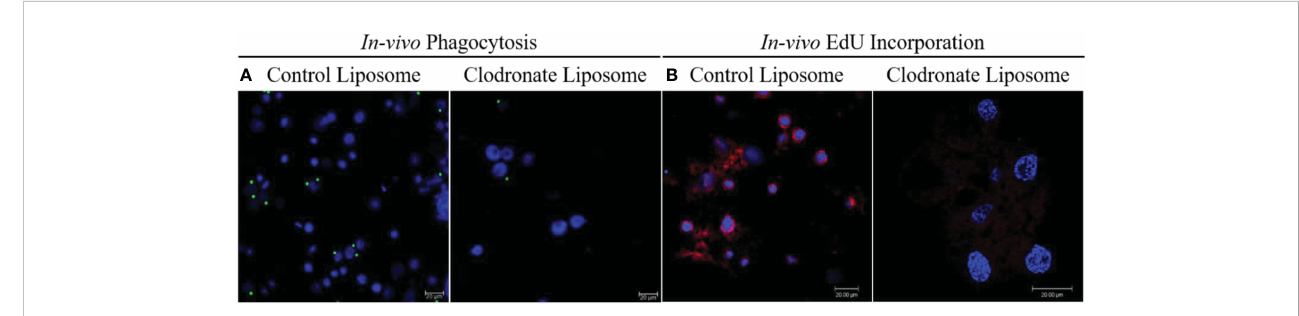
FIGURE 3 Clodronate liposomes deplete hemocyte functions. Clodronate liposomes impaired hemocyte phagocytosis (A) and interfered with EdU incorporation into hemocytes DNA (B) . Scale bar = 20 m m.